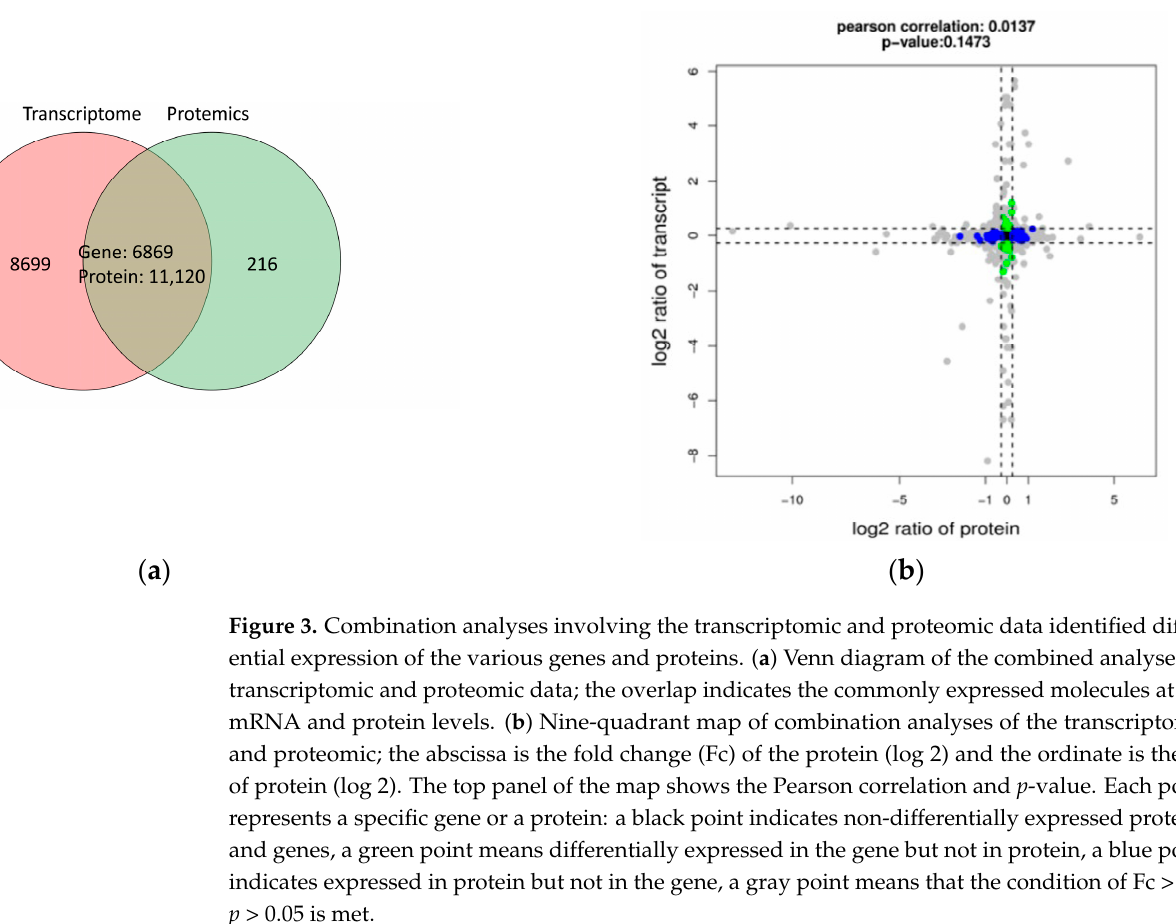
Figure 2. KEGG-enriched pathways of the differentially regulated transcripts ( a ) and proteins ( b ) in bovine chondrocytes between the control and Sr-treated groups. Each circle represents a pathway. The ordinate is the name of the pathway and the abscissa serves as the enrichment factor. The color of the circle represents the q-value, which is the p-value after the multiple hypothesis test correction. The circle size indicates the number of target genes enriched in the pathway. Pathways with redder colors and larger circles exhibited greater reference values. Ten pathways with minimum q-values were displayed in this study.